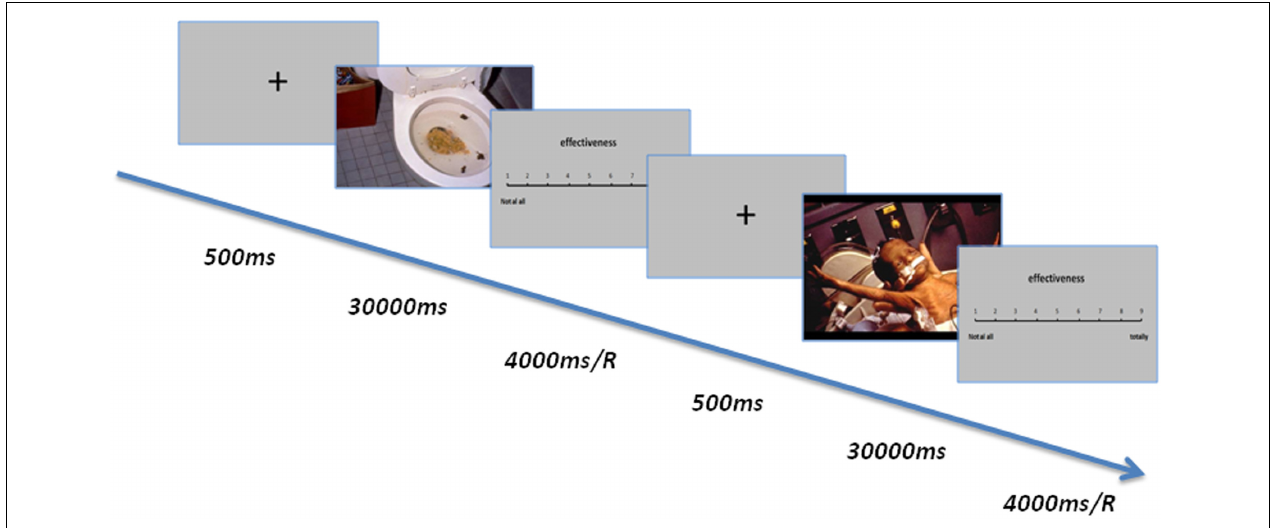
FIGURE 1 | The procedure of experiment 1. The participants were asked to view negative pictures and describe their reappraisals aloud during a 30,000 ms presentation; then, a 9-point scale for effectiveness appeared, and participants were asked to rate the degree of effectiveness in regulating their negative emotion associated with the unpleasant pictures (1 = not at all, 9 = completely). Effectiveness was defined as “the degree or extent to which the reappraisal could improve (which means to decrease the negative emotion or even promote the positive emotion) your feelings toward the